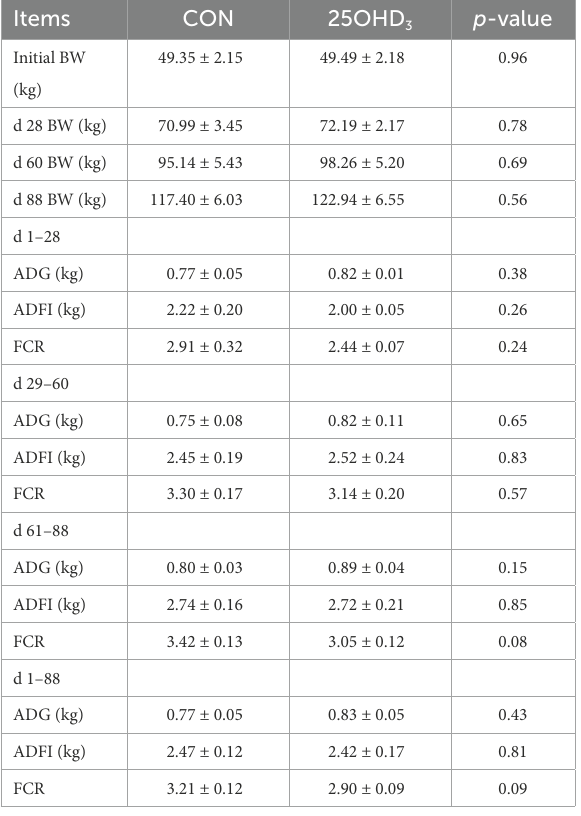
TABLE 3 Effects of 25OHD 3 supplementation on growth performance of growing-finishing pigs.